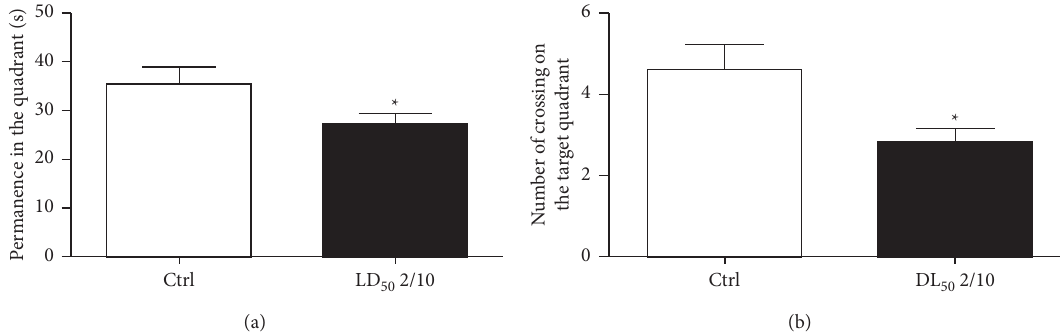
Figure 2: Effect of neonicotinoid mixture oral administration (LD 50 2/10) on the short-term memory of rats. (a) Animals’ permanence time in the quadrant during the memory test. (b) Number of crossings on the target quadrant. Both parameters indicate impairment in the short- term memory test when compared with the control group. All values are given as mean ± SE ( n � 10). ∗ P � 0 . 0447 (a) and ∗ P � 0 . 0193